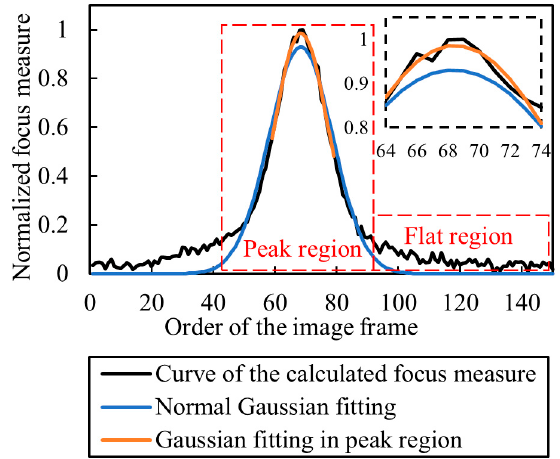
Figure 2. Curve fitting results of different fitting methods.